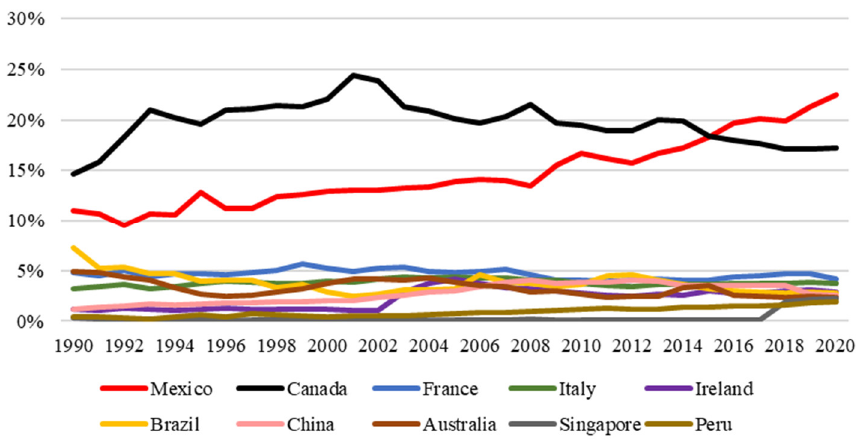
Figure 1. Shares of the top 10 agricultural product import origins of the U.S. from 1990 to 2020. Source: USDA FAS [11].